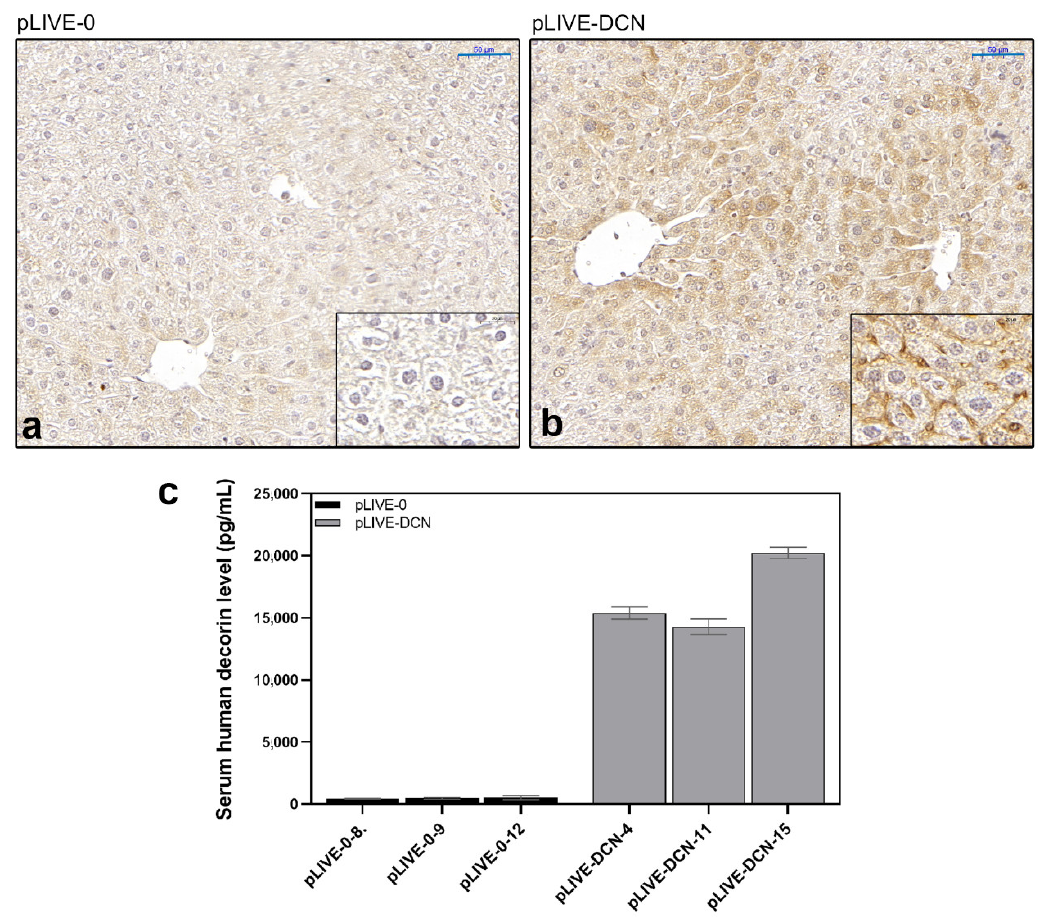
Figure 3. Expression of human decorin in the liver of mock-transfected (pLIVE-0) ( a ) and decorin-transfected (pLIVE-DCN) ( b ) groups. Strong immunopositivity was detected around the central veins and the portal tracts of decorin-transfected livers. ( c ) Human decorin ELISA from sera of control (pLIVE-0) and decorin-transfected (pLIVE-DCN) groups following c38 injection. The absolute proteoglycan level is marked on the y -axis (pg/mL) and individual mice are shown on the x -axis (n = 3 in both groups). Data are displayed as mean ± SD. Scale bar = 50 μm.